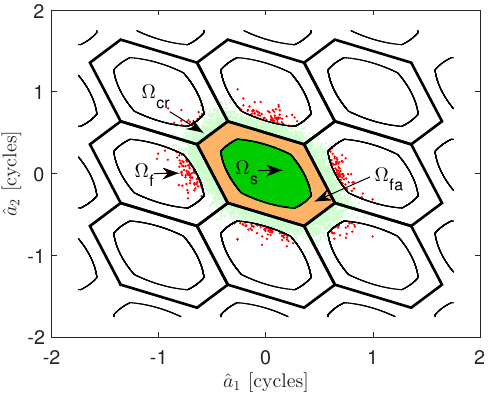
Figure 1. The two-dimensional acceptance region of the Fixed Failure-rate Ratio Test (FFRT). The green and red areas are the regions of correct acceptance and incorrect acceptance. The orange and light green areas are the region of false alarm and correct